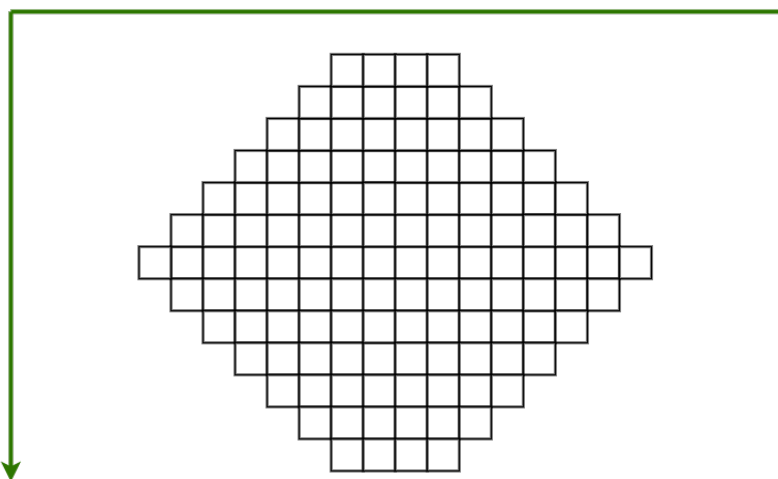
Figure 8. Example of filtered 2D matrix where the blank spaces represent the values of zero and the squares represent the object’s surface